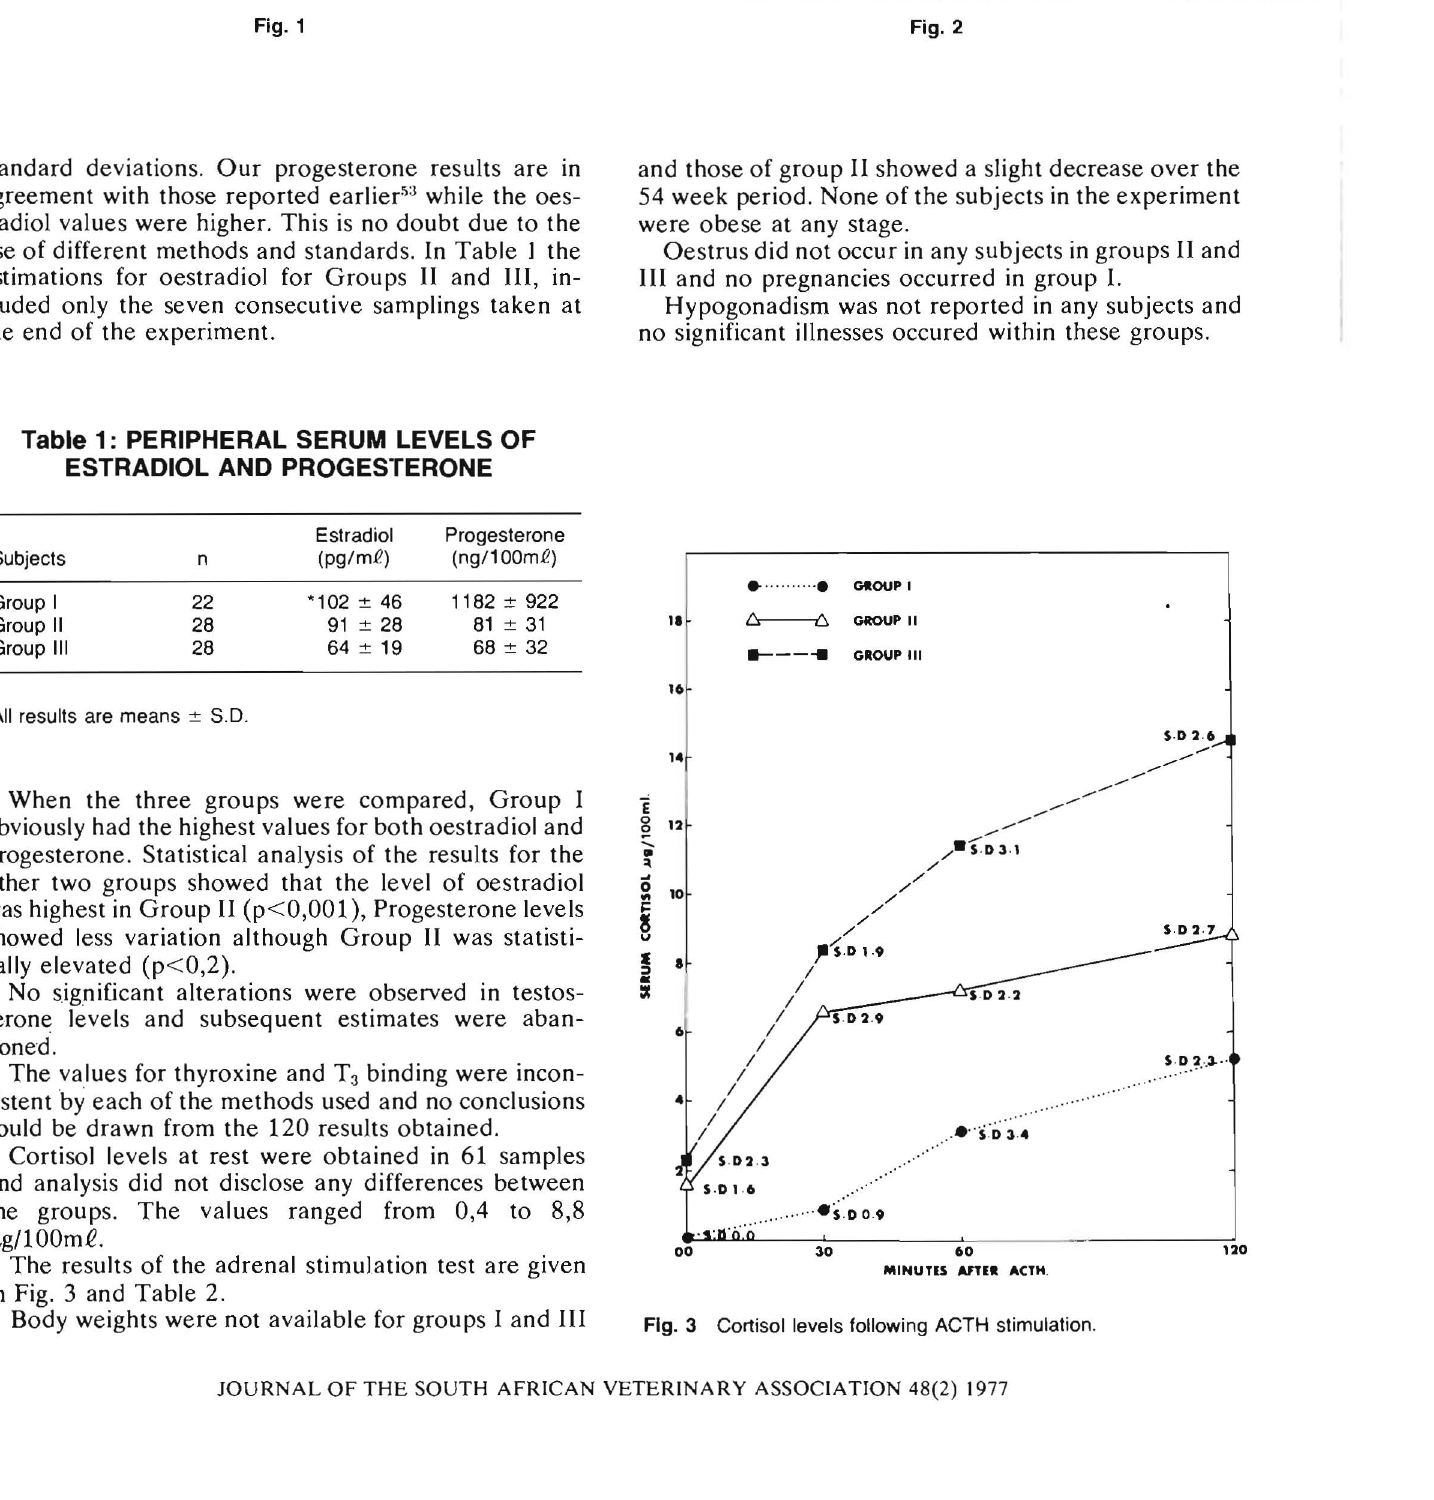
and those of group II showed a slight decrease over the 54 week period. None of the subjects in the experiment were obese at any stage.